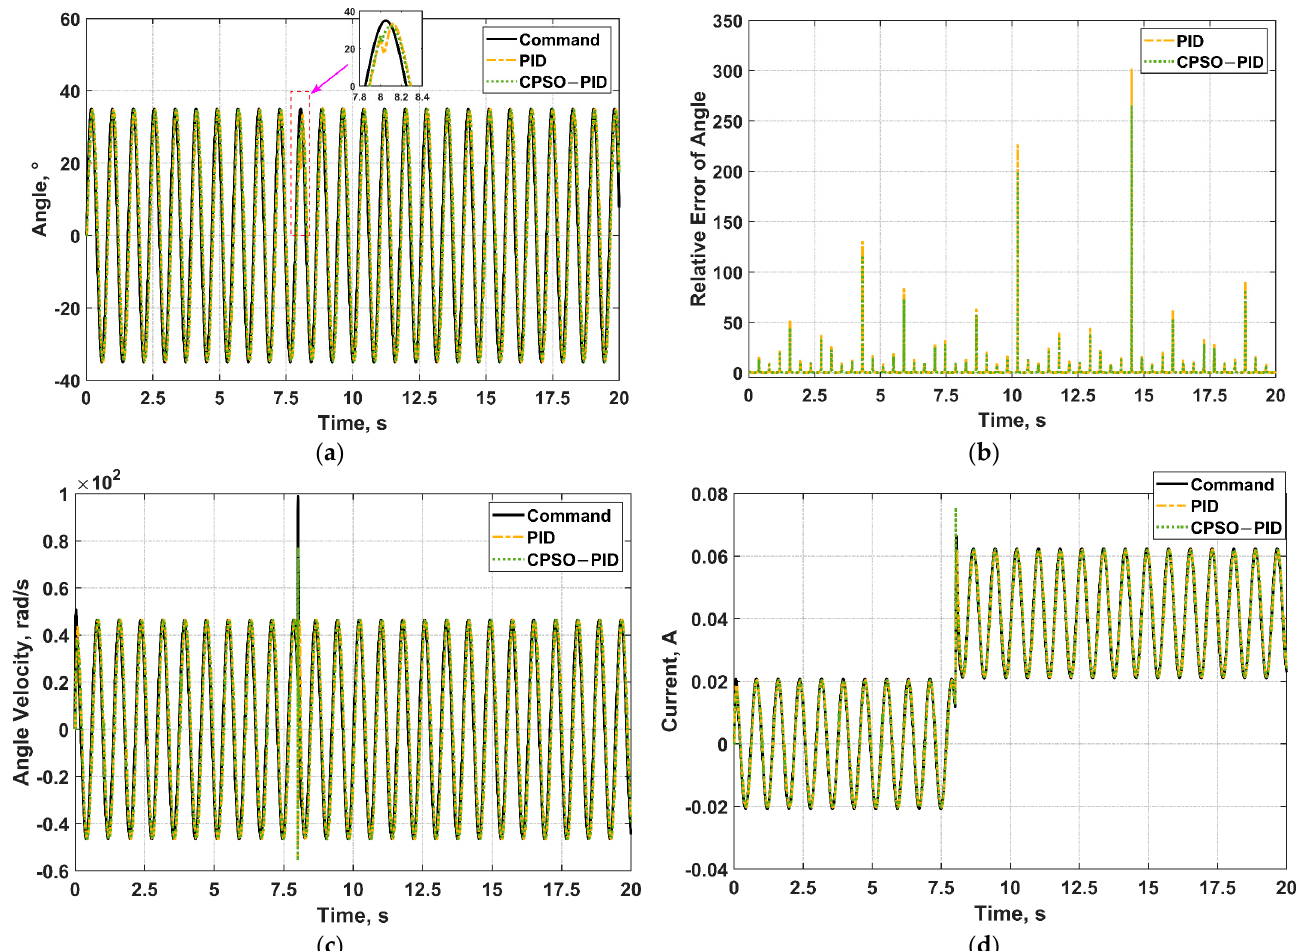
Figure 13. The simulation result when the angle command input signal is a sine wave with frequency of 8 rad/s adding a step load at t = 8 s. ( a ) Angle control; ( b ) Relative error of angle; ( c ) Angle velocity control; ( d ) Current control.